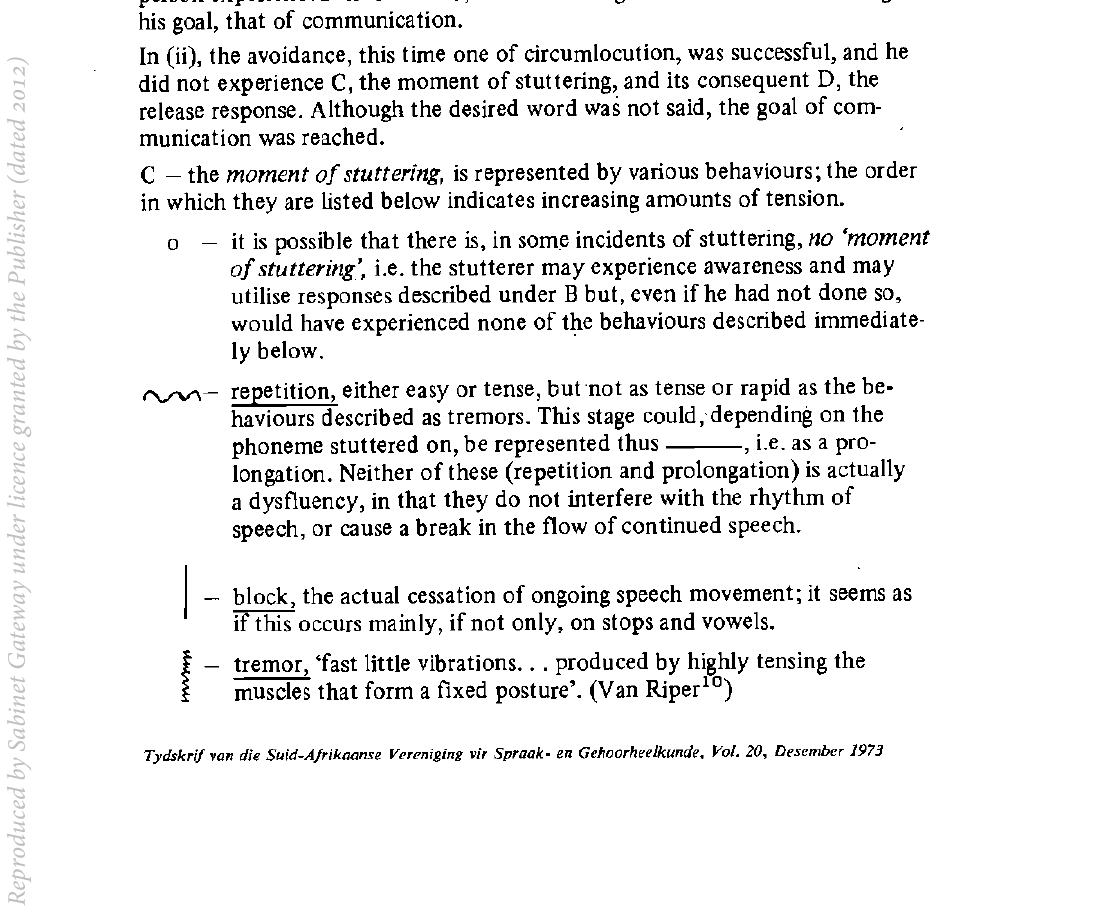
Figure 2: Representations of